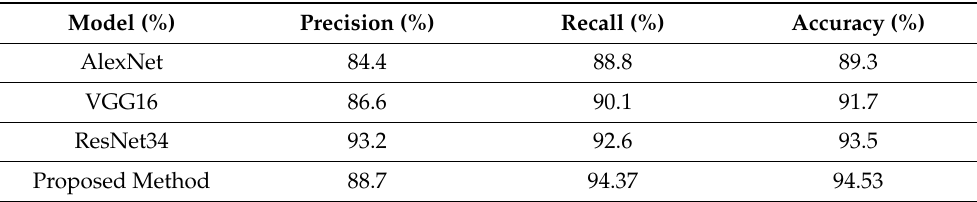
Table 4. Summary of the predictive performance of the pre-trained models, AlexNet, VGG16, and ResNet34, and the proposed method.